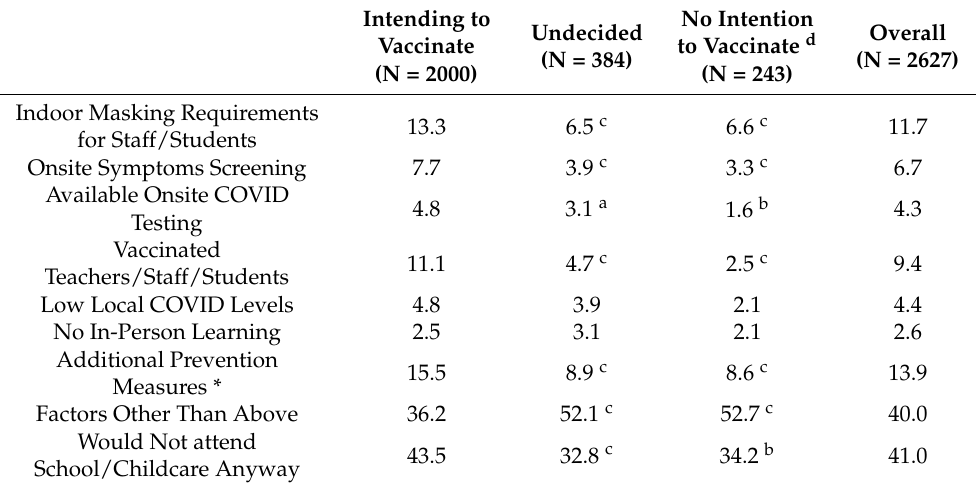
Table 4. Percentages of parents endorsing factors that informed a decision to have their children not attend in-person class or childcare stratified by intention to vaccinate